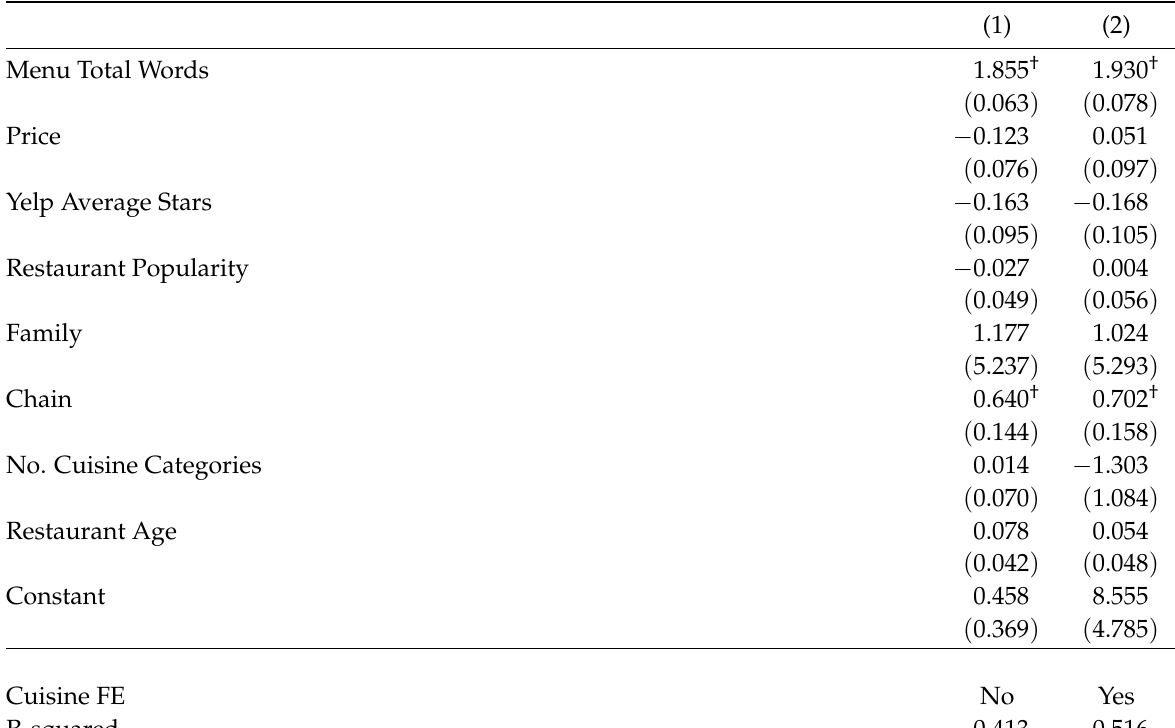
Table 4: OLS estimates of menu authenticity